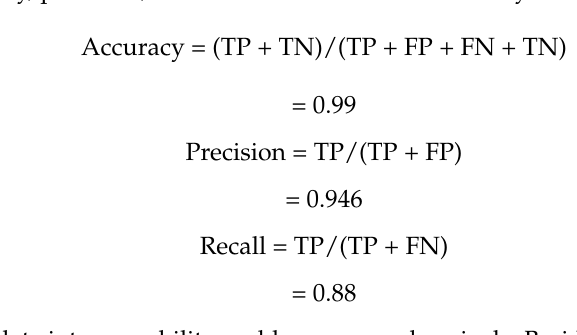
Manual Checking True False Positive TP = 88 FP = 5 Negative TN =